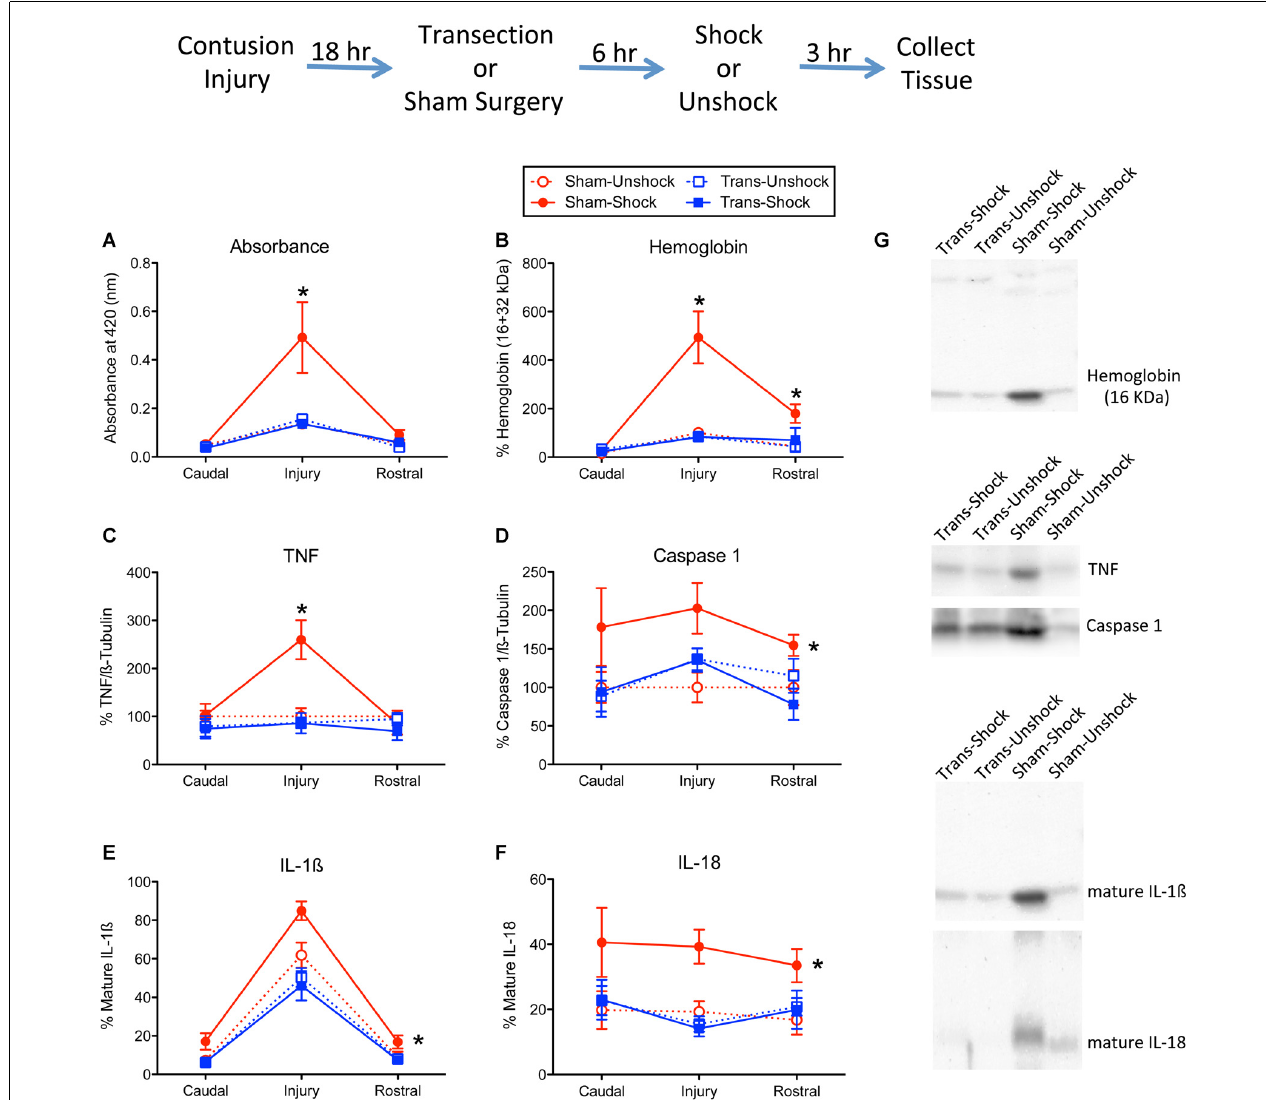
FIGURE 1 | Impact of shock on indices of hemorrhage and signals linked to inflammation and cell death. The experimental design is illustrated at the top of the figure. Eighteen hours after rats received a lower thoracic (T11–12 vertebrae) contusion injury, animals received a T2 spinal transection (Trans) or sham surgery. Six hours later, animals were exposed to noxious electrical stimulation (Shock) to the tail, or nothing (Unshock) and 3 h later a 1 cm portion of the spinal cord that encompassed the injury was collected. Additional tissue, 1-cm rostral and caudal to injury, was also obtained and prepared for cellular assays. Protein samples from non-transected animals that received shock (Sham-Shock) exhibited greater (A) absorbance at 420 nm, the absorption peak for hemoglobin. Western blotting showed that animals in the Sham-Shock group had higher levels of (B) alpha hemoglobin, (C) tumor necrosis factor (TNF), (D) caspase 1, (E) interleukin-1 β (IL-1 β ), and (F) IL-18 at the site of injury. Nociceptive stimulation had no effect in animals that had received a spinal transection (Trans-Shock). (G) Representative blots from the injury center are depicted to the right of the figures. Error bars indicate the standard error of the mean (SEM). An asterisk above an error bar indicates that the effect of nociceptive stimulation was significant for that region of the spinal cord ( p < 0.05, n = 6). An asterisk placed to the right indicates that stimulation had a broader effect that did not vary across the regions